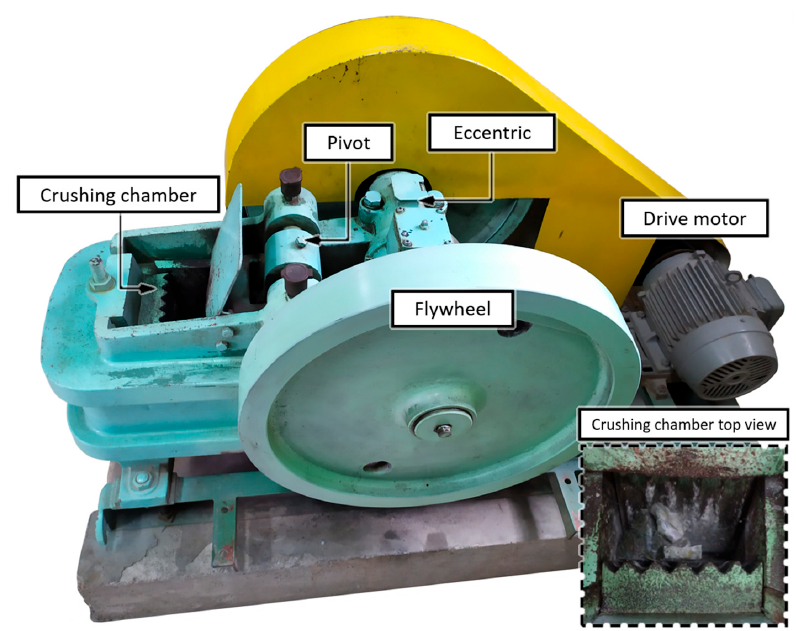
Figure 2. Laboratory-scale jaw crusher at the Colombian Geological survey, with the insert showing the top view of the crushing chamber.